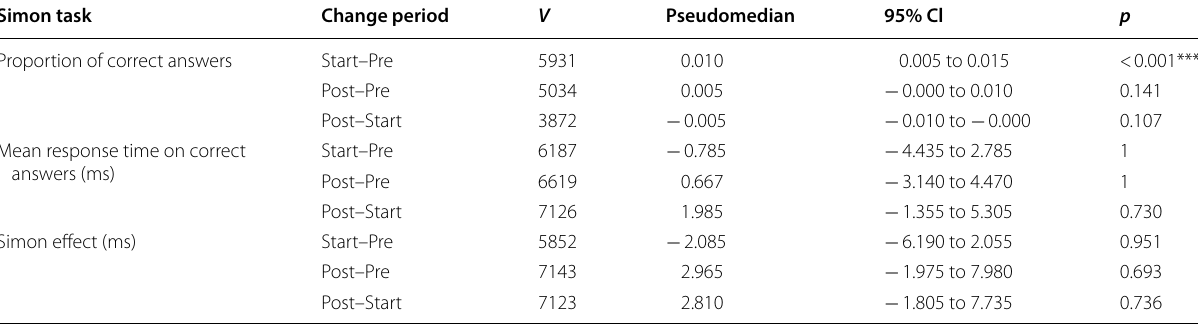
Table 4 Changes in Simon task outcomes across study parts (all materials combined)—results of Wilcoxon signed rank